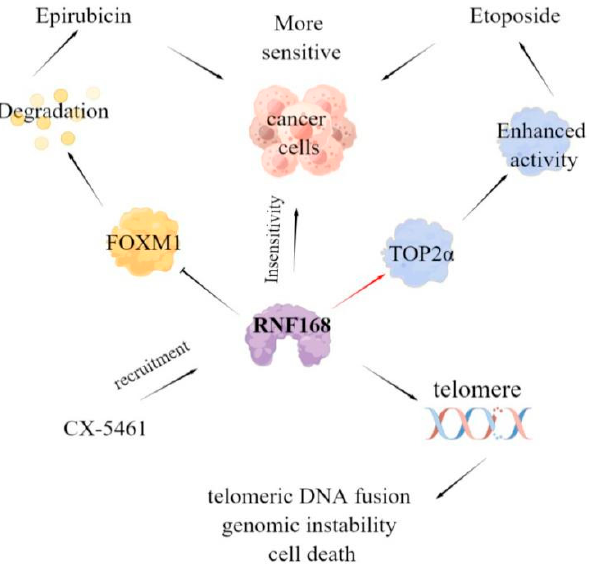
Figure 5. Relationship between RNF168 and tumorigenesis and development. RNF168 can increase the expression of cancer-promoting factors, such as STAT1, WNT3A, β -catenin, and ER α , so it is highly expressed in some cancer cells. RNF168 can promote the degradation of cancer-promoting factors, such as RHOC, or recruit 53BP1 to inhibit HR and cause cell death, so it is lowly expressed in some cancer cells.